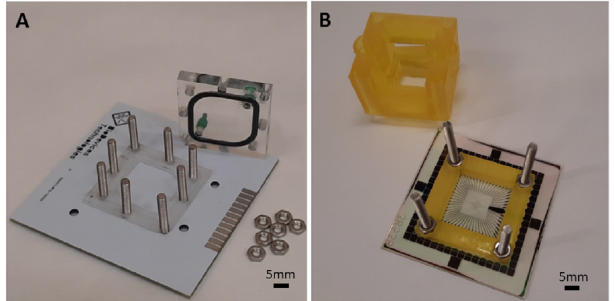
Figure 1. Culture chambers. ( A ) Culture chamber composed of PCB as substrate and a fluidic system made of PMMA. ( B ) Culture chamber composed of MEA from MultiChannel systems (MCS) as substrate and a fluidic system made of Uniz zSG amber resin.